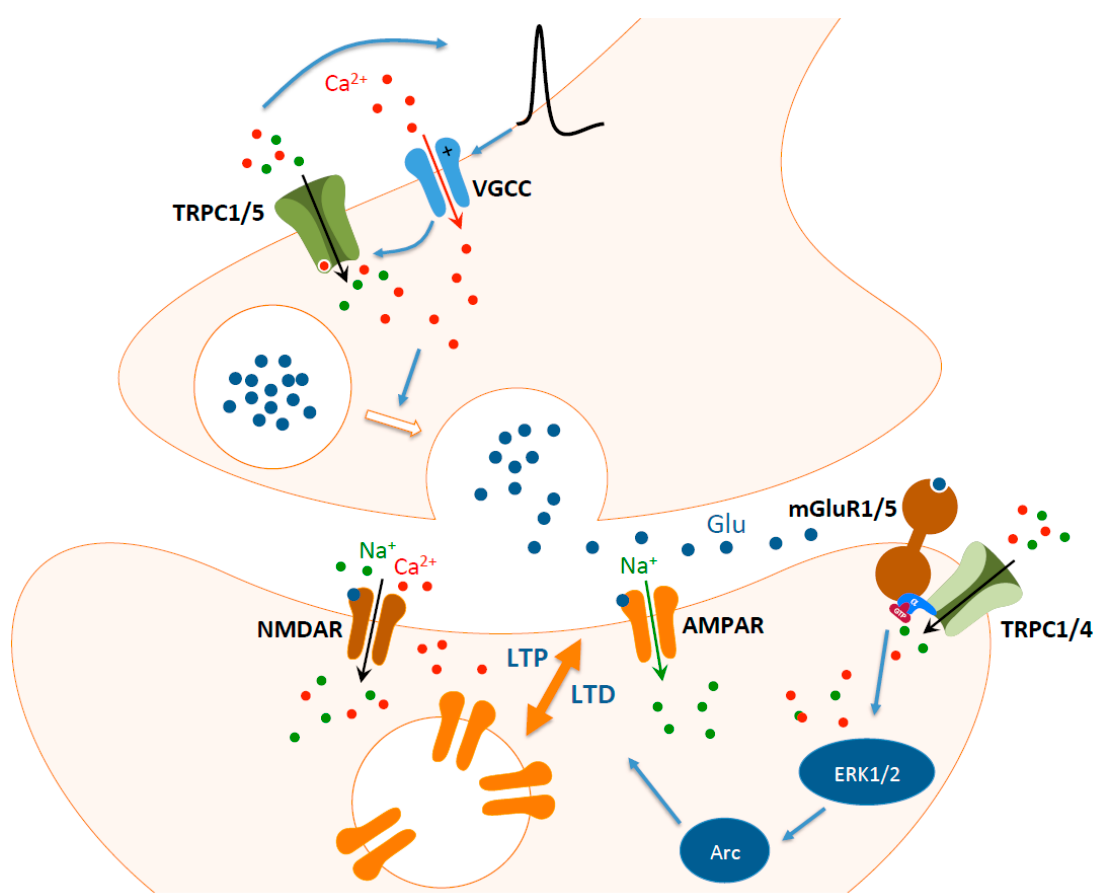
Figure 1. Hypothetical role of transient receptor potential canonical (TRPC) channels in Schaffer collateral-CA1 synapses. In the presynaptic terminal, the entry of Ca 2 + through voltage-gated Ca 2 + channels (VGCC) during action potential activates TRPC5 homotetramers or TRPC1 / C5 heterotetramers, which increases depolarization and exerts a positive feedback, thereby modulating presynaptic Ca 2 + dynamics and improving neurotransmission. In the postsynaptic terminal, glutamate released activates α -amino-3-hydroxy-5-methyl-4-isoxazolepropionic acid receptors (AMPAR). If the depolarization is su ffi cient (for example after a high frequency burst of action potentials), glutamate also activates N-methyl-D-aspartate receptors (NMDAR) allowing an influx of Ca 2 + that increases the number of AMPAR at the membrane and produces long-term potentiation (LTP). In contrast, low-frequency stimulation increases more modestly postsynaptic [Ca 2 + ] i, which decreases the number of AMPAR at the membrane and produces long-term depression (LTD). In both LTP and LTD, a concomitant activationofperisynapticmetabotropicglutamatereceptorsmGluR1and / ormGluR5activatesTRPC1 / C4 heterotetramers that further depolarize the postsynaptic terminal and induce an entry of Ca 2 + . This, in turn, modulates the activity of extracellular signal-regulated kinases 1 / 2 (ERK1 / 2), the subsequent expression of the activity-regulated cytoskeletal-associated protein Arc, an immediate early gene that controls AMPA receptors